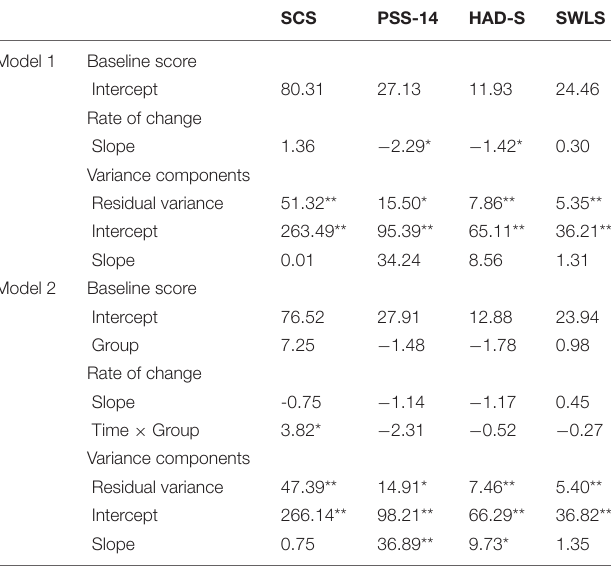
TABLE 2 | Mixed-effects growth models estimating changes over